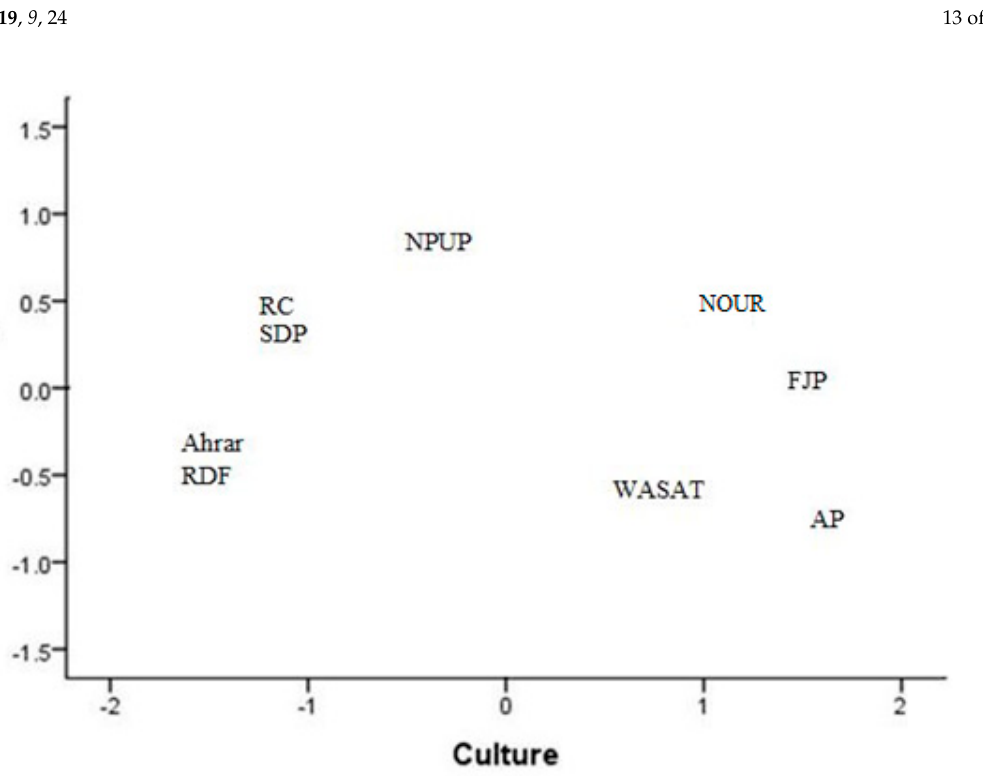
Figure 10. Ideological map of Egyptian parties, 2011. Al-Nour Party, RC: Revolution Continues; SDP: Social Democratic Party; Wasat; FJP: Freedom and Justice Party; AP: Authenticity Party.